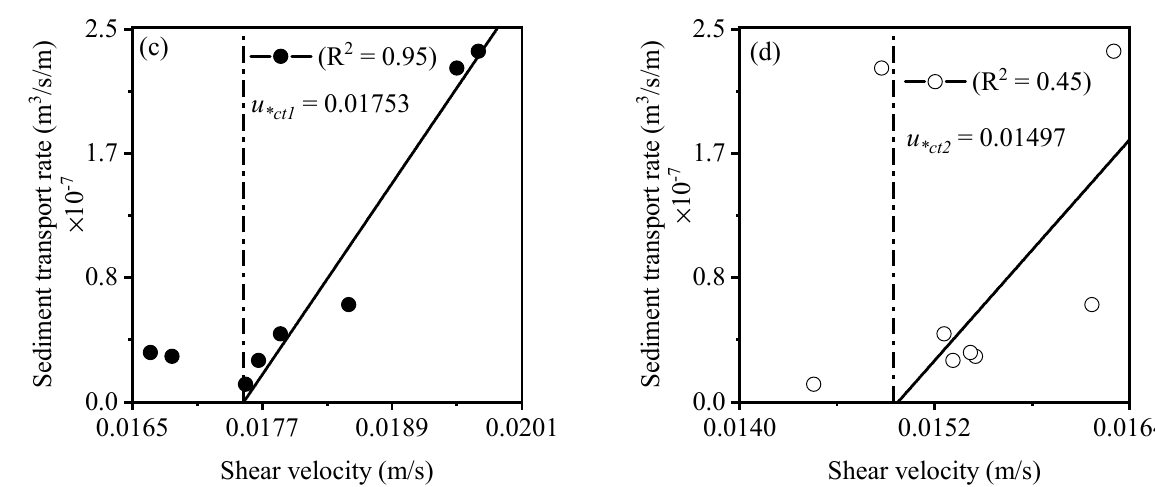
Figure 10. Estimation of critical shear velocity from shear velocity calculated by different indirect methods at upstream edge of sand zone: ( a ) curve fitting to universal logarithmic law; ( b ) Reynolds shear stress; ( c ) turbulence intensity considering x -component of flow; and ( d ) turbulence intensity considering y -component of flow.